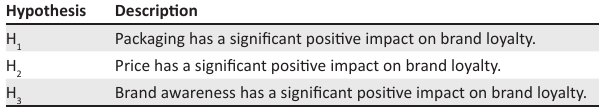
Packaging Price loyaltyH